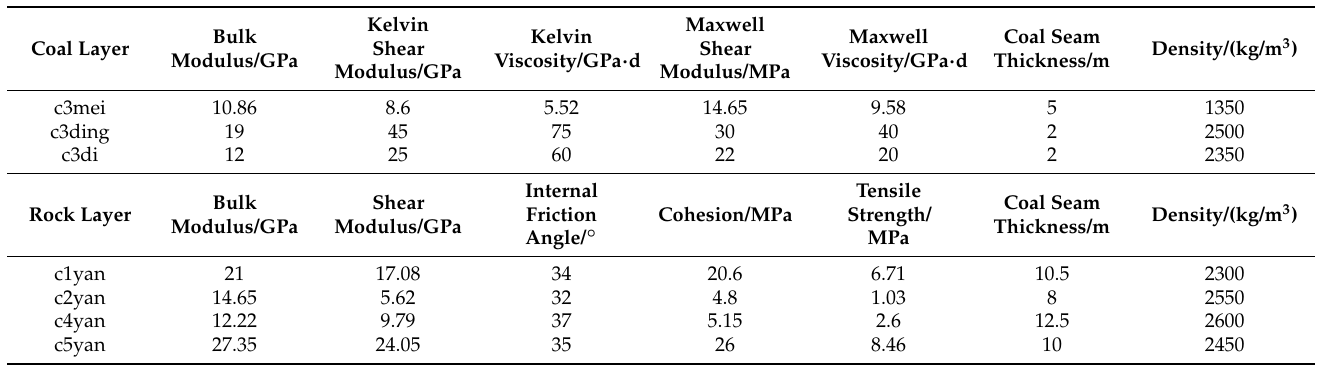
Table 3. Parameter measurement of each coal seam.